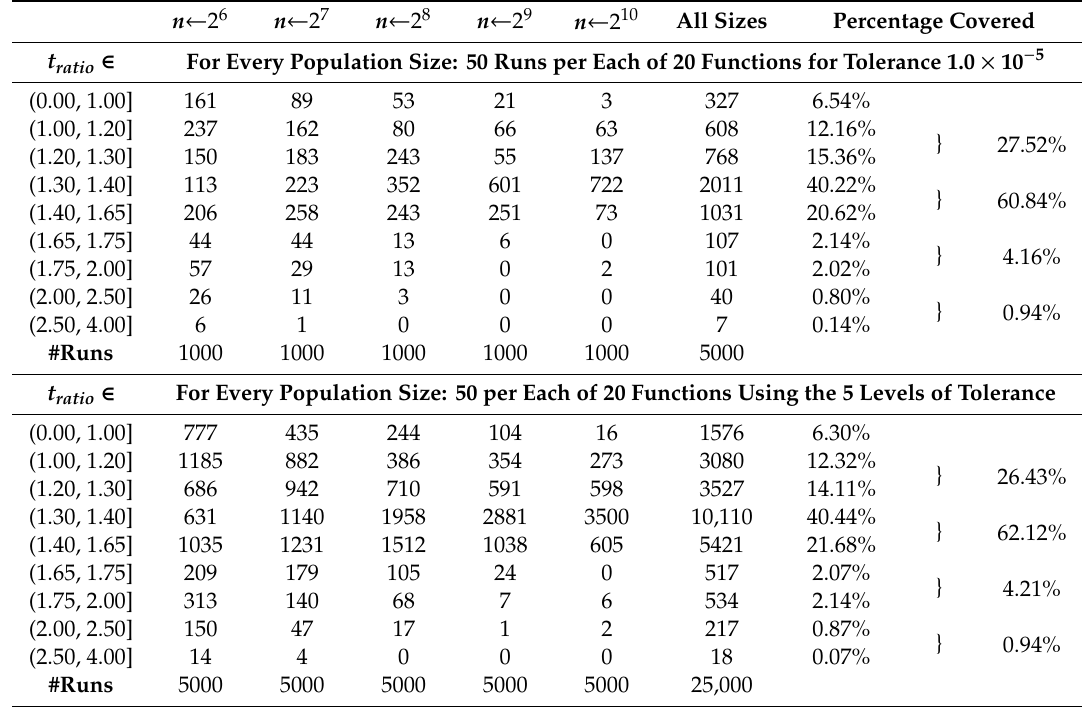
Table A3. Number and percentage of runs covered by di ff erent ranges of time ratio.